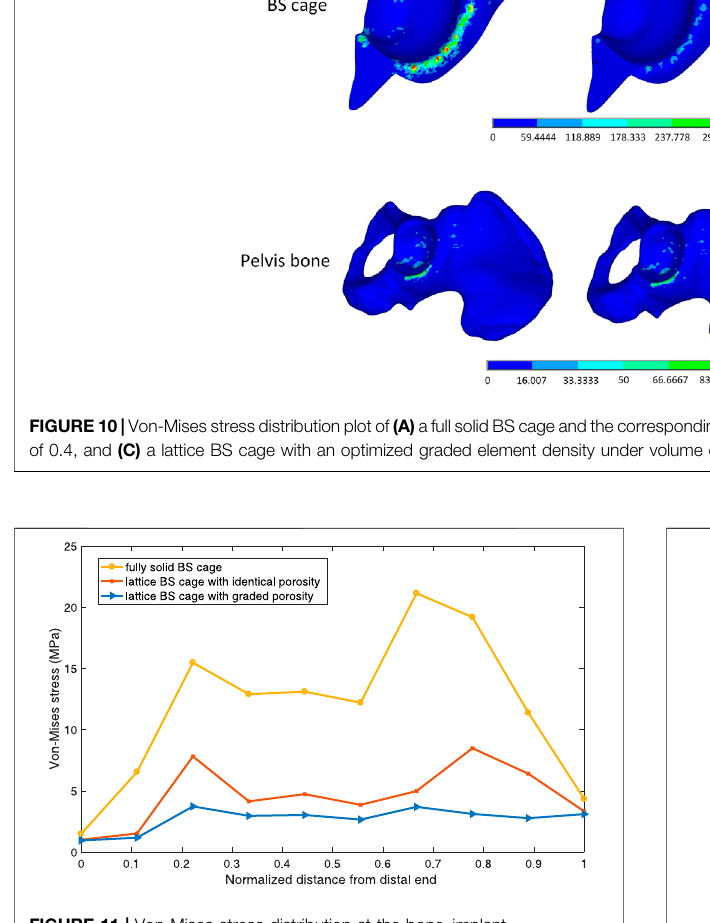
FIGURE 11 | Von-Mises stress distribution at the bone – implant interface.